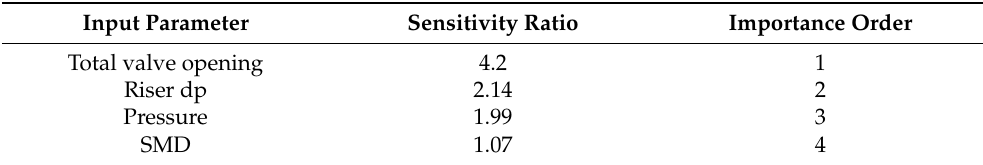
Table 10. Sensitivity